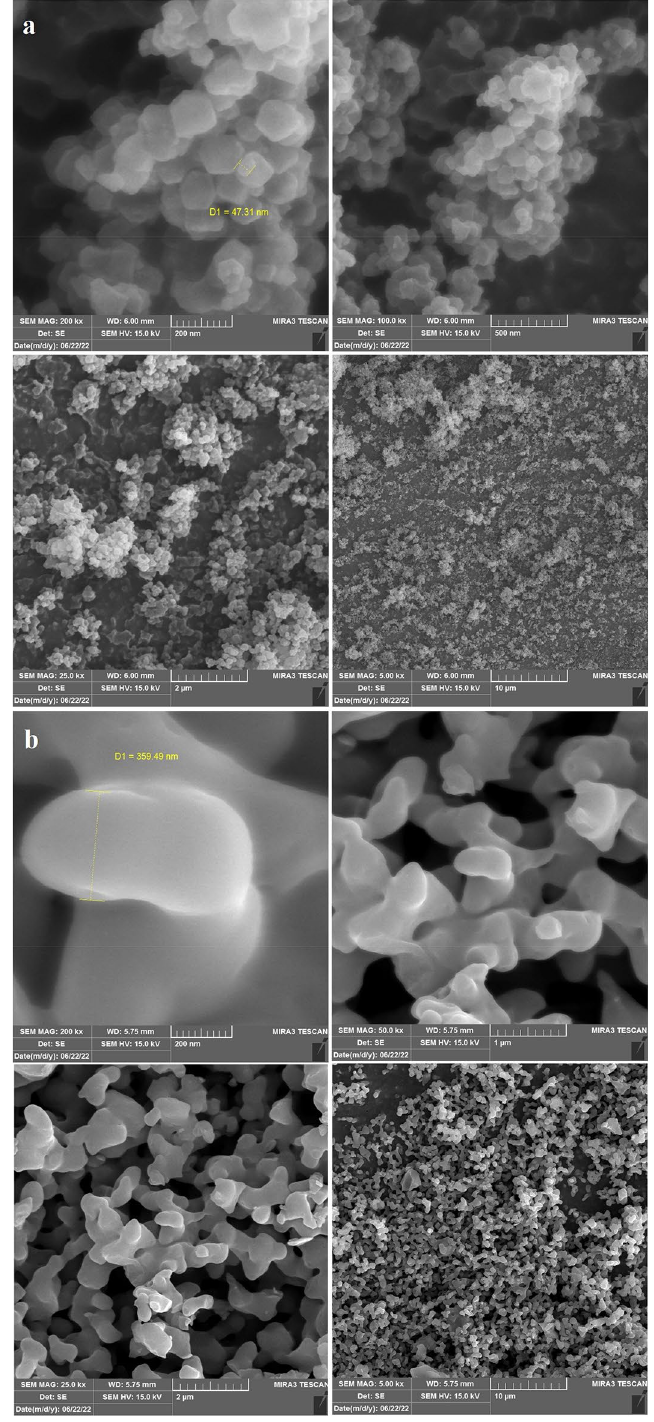
Figure 8. FESEM images of ( a ) NiCoZn-ZIF and ( b )